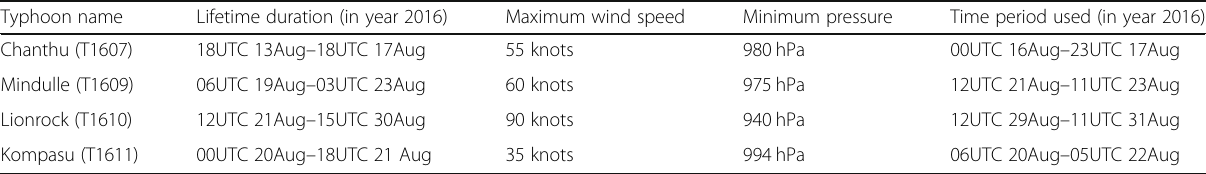
Table 1 Overview of each typhoon and time periods used in this study Typhoon